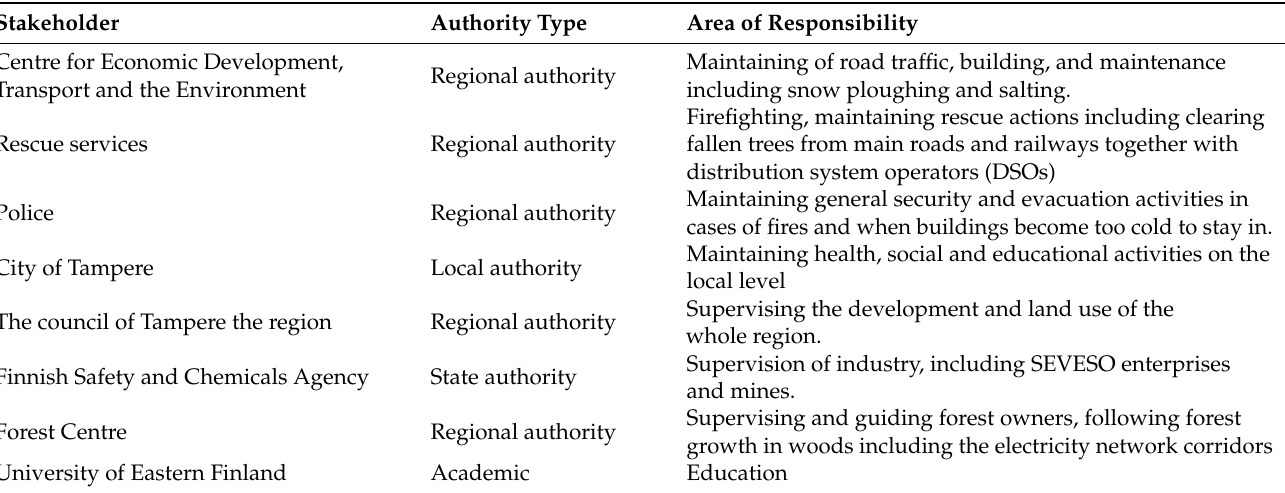
Table 1. The participants of the stakeholder workshop regarding the cascading effects of a snowstorm and cold